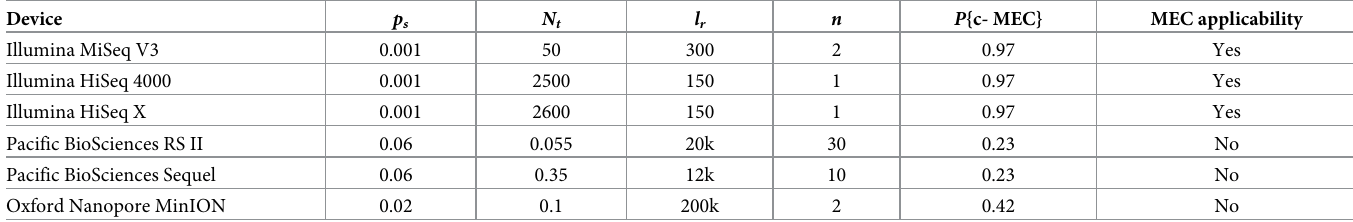
Table 1. Comparison MEC applicability of different sequencing devices, for the substitution error probability p s , the total number of reads N t in millions, the read length l r and the number of runs n needed for a coverage of 10. For Illumina technology, the read length corresponds to the paired-end